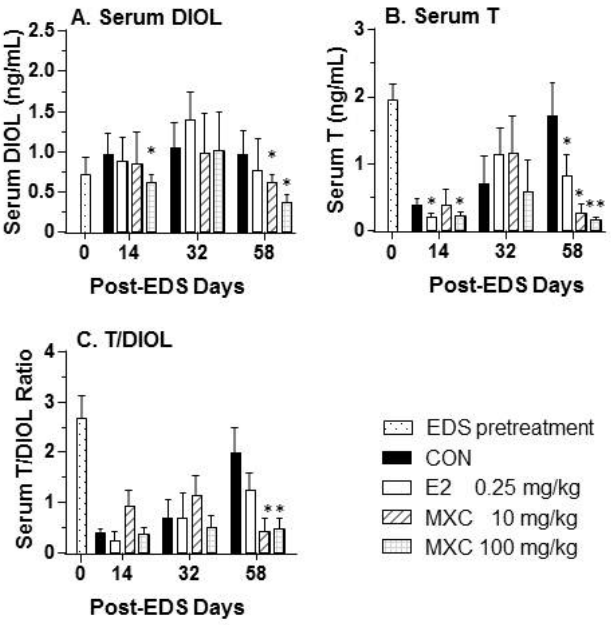
Figure 1. Serum testosterone (T) and 5 α -androstane-3 α ,17 β -diol (DIOL) levels after treatment of estradiol (E2) or methoxychlor (MXC) from days 5 to 30 post-EDS. ( A ) DIOL; ( B ) T; ( C ) T/DIOL ratio. Mean ± SEM, n = 5. *, ** indicate significant difference when compared to control (CON) at each time point at p < 0.05 and 0.01,